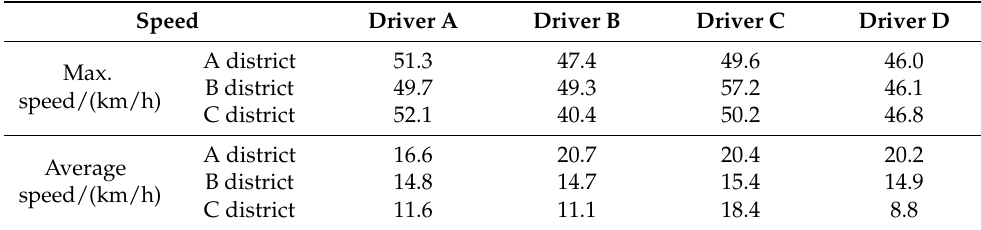
Table 4. Speed from different drivers.